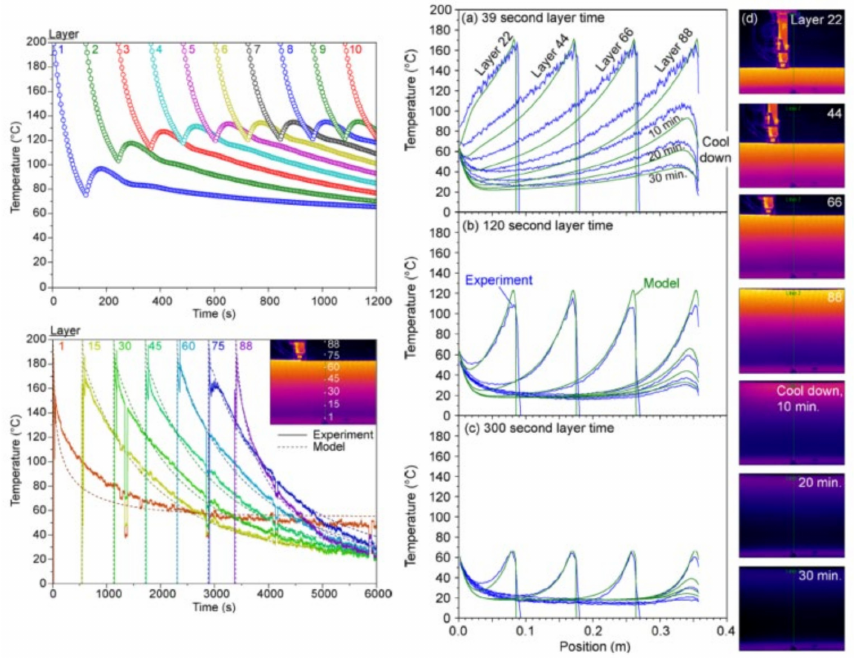
Figure 7. Temperature profile obtained from both experimental and numerical approaches for different layers (reprinted with permission from